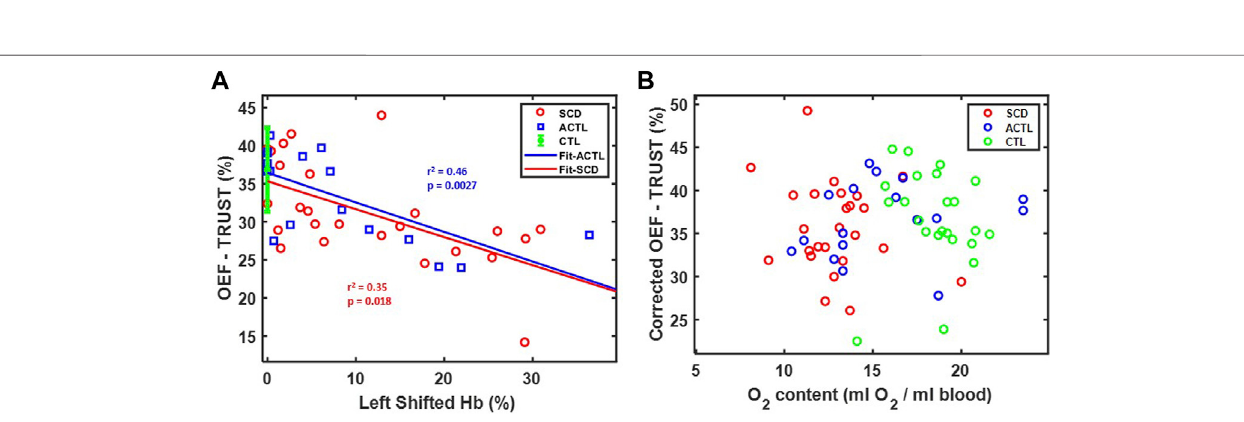
Frontiers in Physiology |